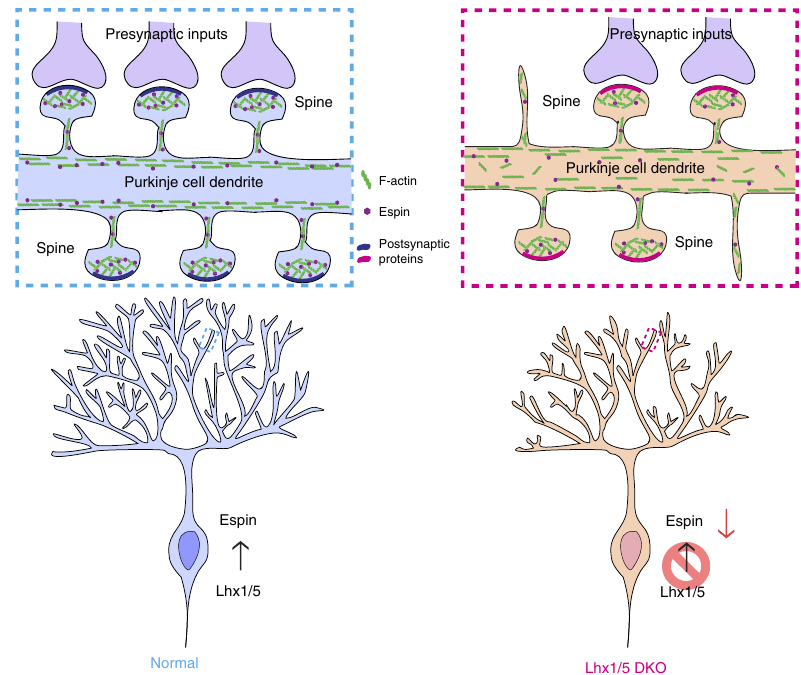
Figure 10 | Summary illustration of the role of Lhx1/5 in PC dendritogenesis and spine morphogenesis. In normal mouse cerebellum, Lhx1/5 activate the expression of Espin that regulates the organization of F-actin in PC dendrites and thereby controls dendritogenesis and spine morphogenesis of PCs. The dendritic spines can maturate normally and form synapses with the presynaptic inputs. In Lhx1/5 DKO mutant cerebellum, Espin expression is downregulated due to inactivation of Lhx1/5 . As a result, less Espin can be found in PC dendrites and thus F-actin becomes disorganized in PC dendrites. This disrupts dendritogenesis and the maturation of dendritic spines and results in loss of synapses with some presynaptic